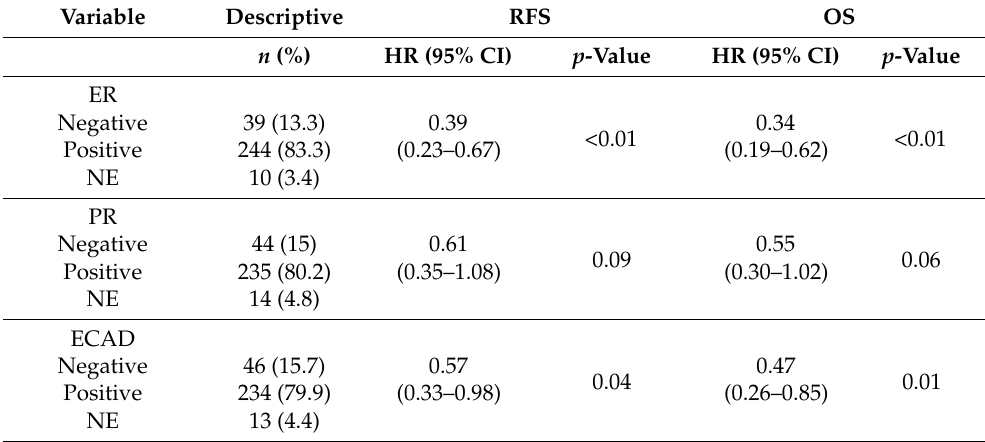
Table 3. Univariate biomarker analysis for relapse-free survival and overall survival.